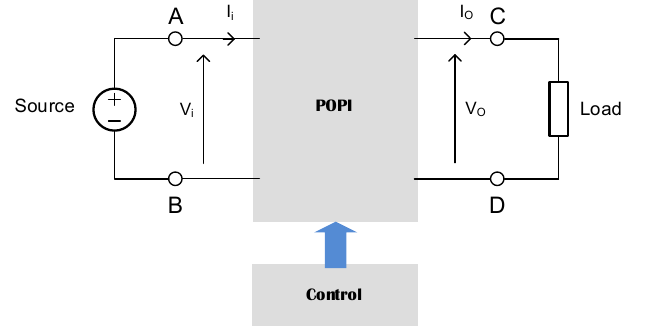
Figure 4. Source–load coupling by means of POPI network. Transformers, gyrators and loss-free resistors (LFRs) are among the elements in the POPI family (Figure